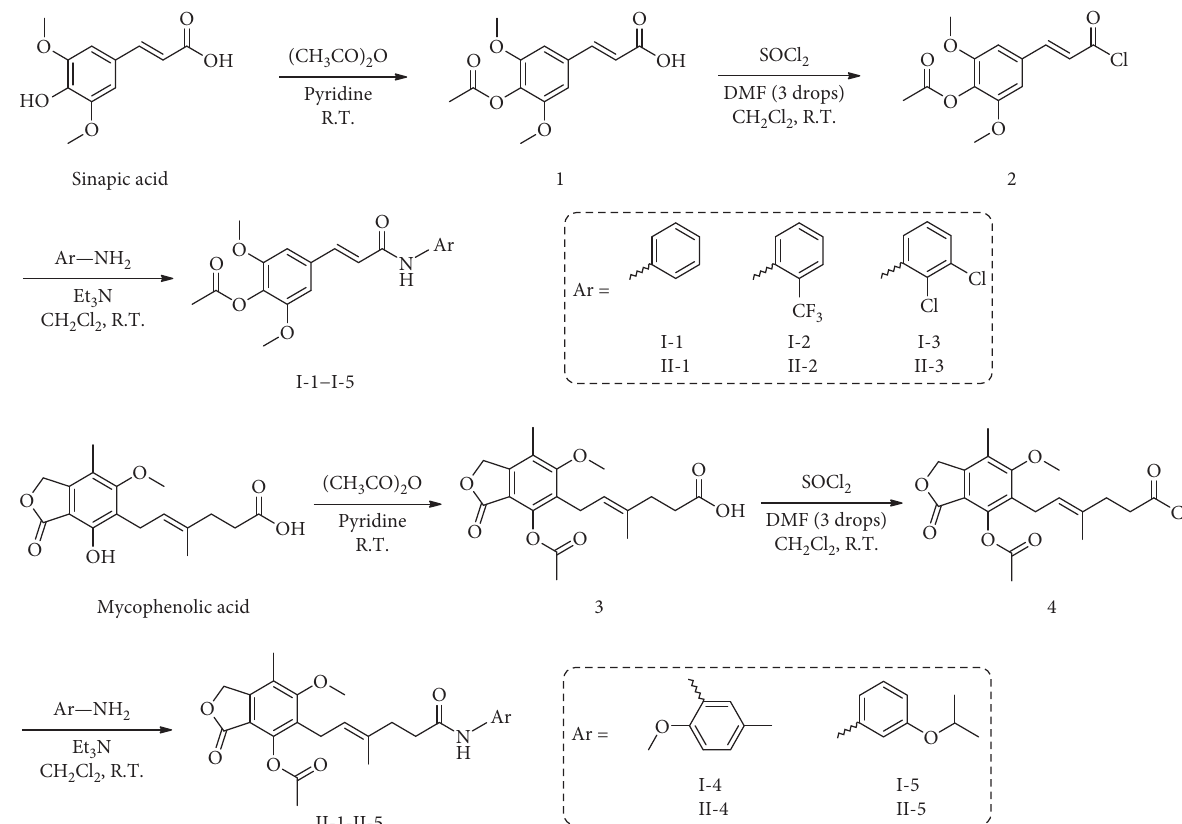
Scheme 1: The synthetic procedures for the target molecules I and II